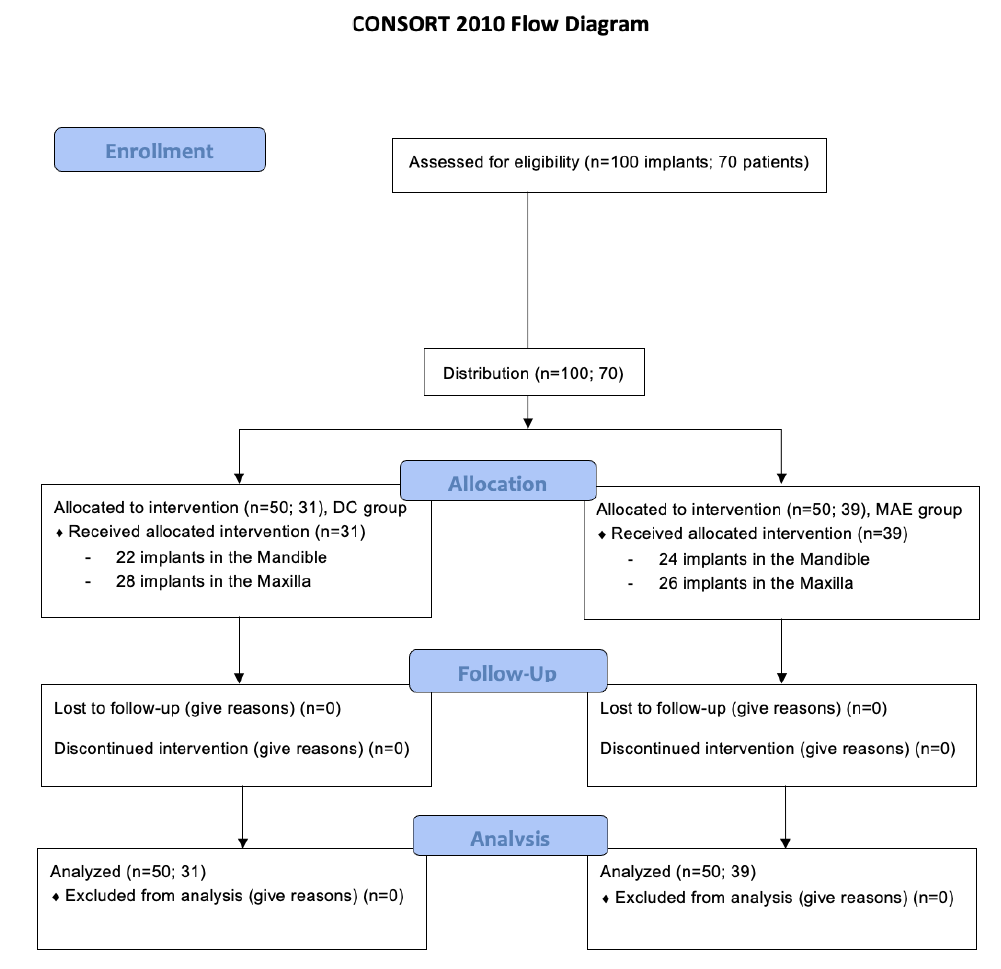
Figure 2. The CONSORT 2010 flow diagram. Figure 2 . The CONSORT 2010 flow diagram.